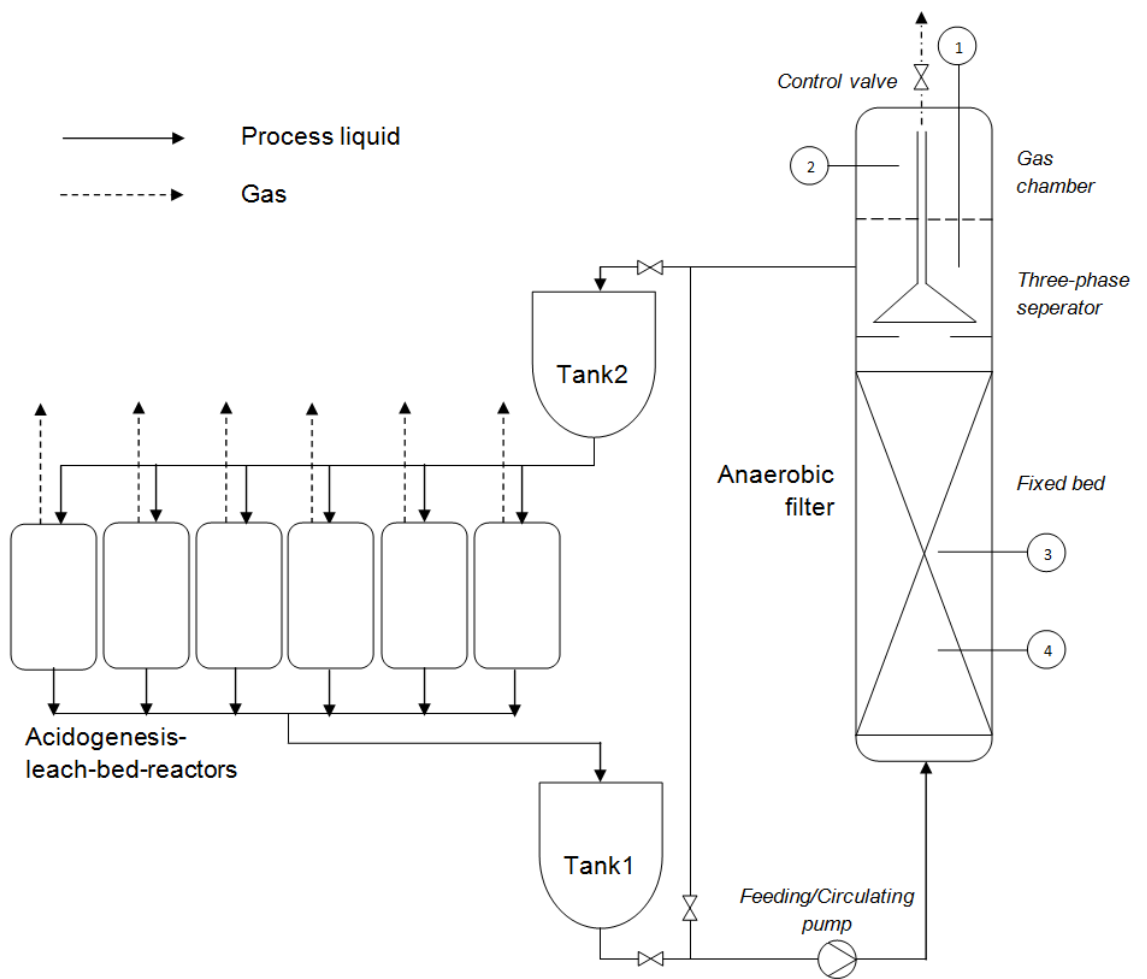
Figure 1. Schematic diagram of the two-phase pressurized anaerobic digestion system (Sensors: 1: Liquid level sensor; 2: Pressure sensor; 3: pH sensor; 4: Temperature